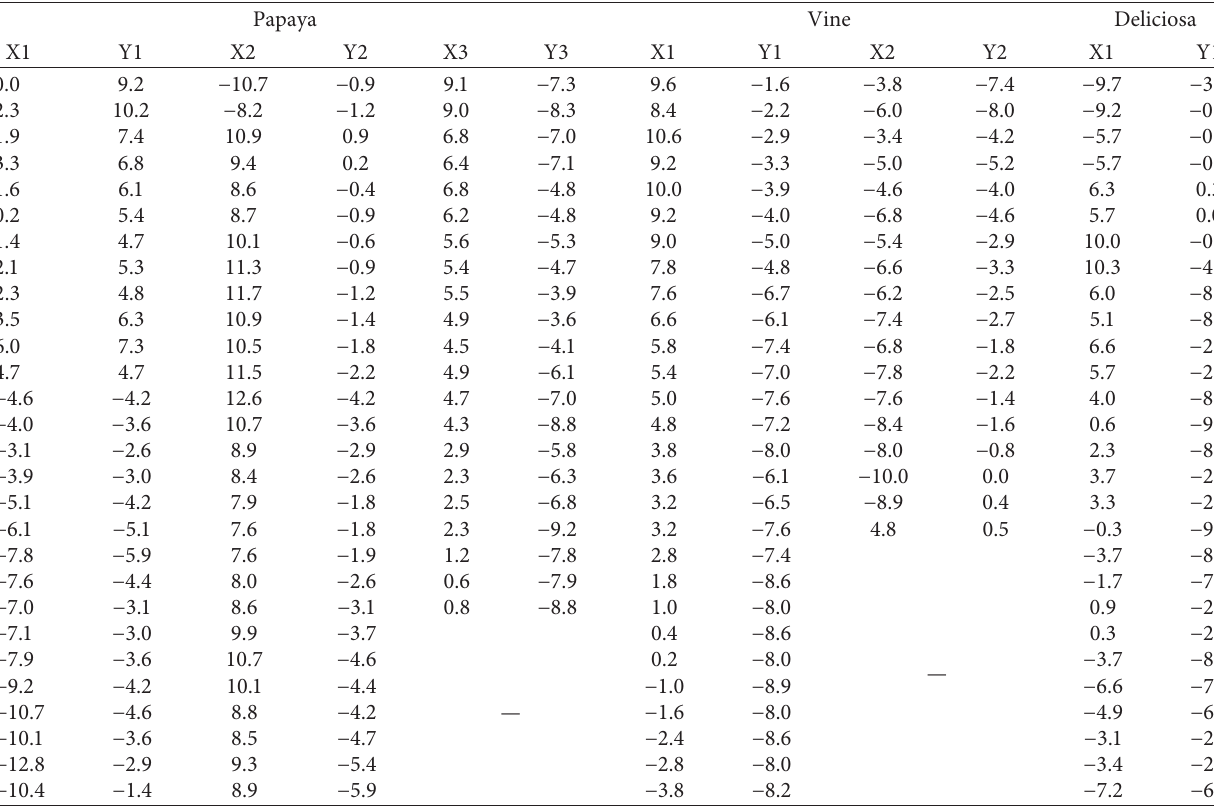
Table 2: The coordinates of the shape of the radiating patch. Papaya Vine Deliciosa